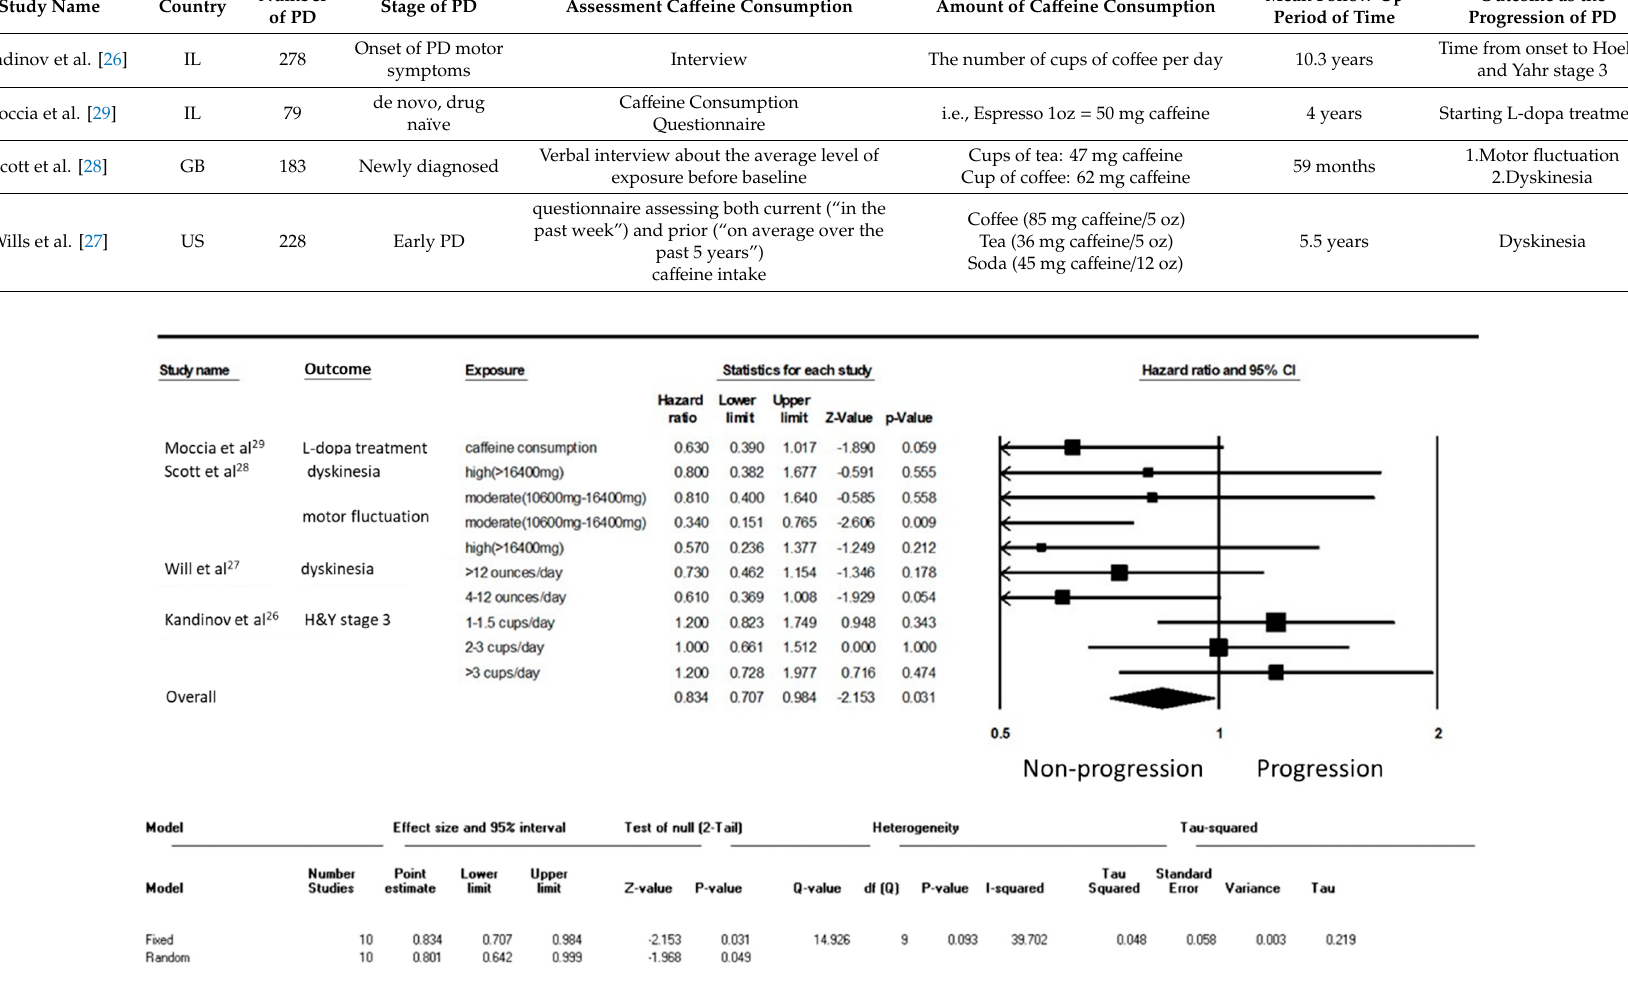
Figure 3. Forest plot illustrating the hazard ratio (HR) of progression of Parkinson’s disease (PD) among individuals with early-stage P.